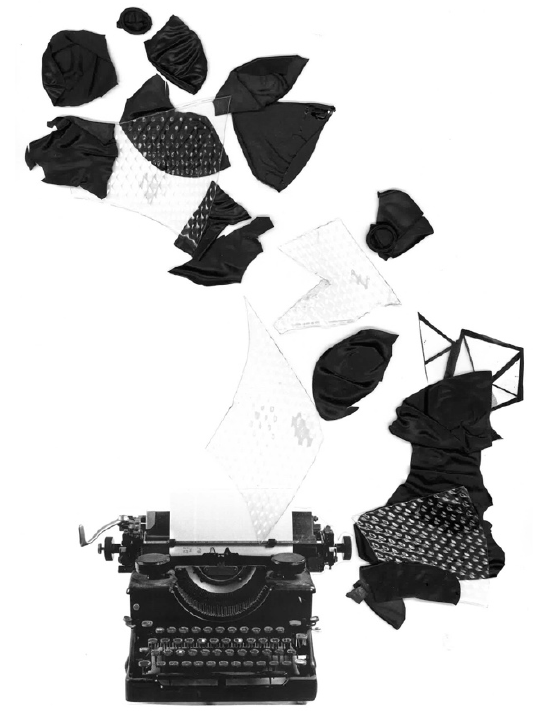
Figure 2. Studio 5 The Stars